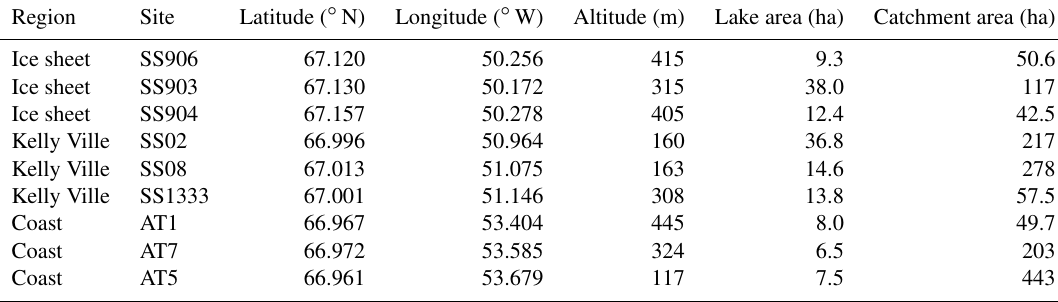
Table 1. Sampling catchment details (based on centroid of